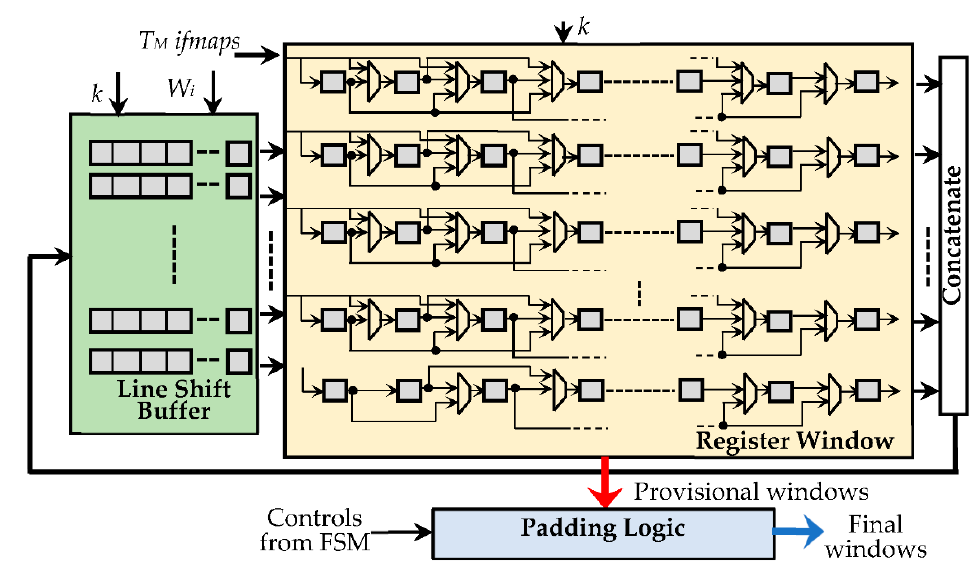
Figure 7. The organization of the ifmaps buffer.